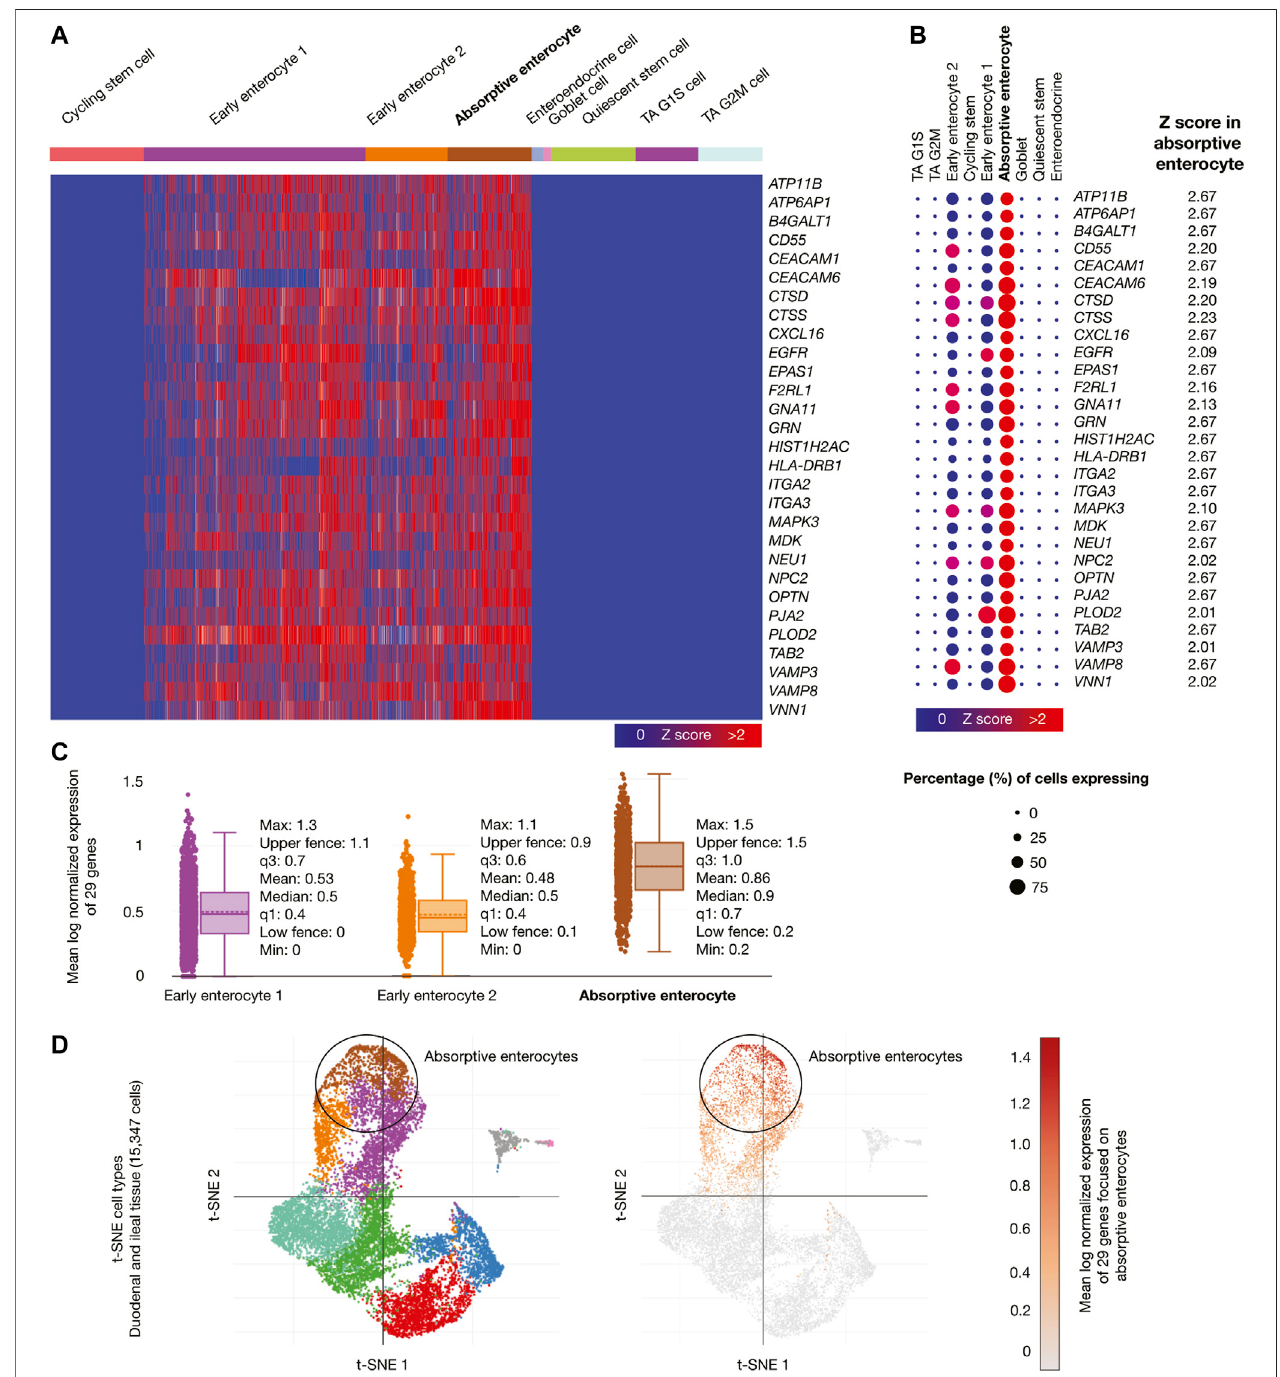
FIGURE 6 | Single-cell RNA-sequencing data analysis of the high-con fi dence immune system nodes in intestine cells. (A) Heatmap of signi fi cant overexpressed genes(Z-score > 2) inilealabsorptiveenterocytes. (B) Dotplot ofsigni fi cantoverexpressedgenesin ilealabsorptive enterocytes and percentageofcells expressing. (C) Box plots of intestine cell types according to their mean log normalized expression. (D) t-distributed stochastic neighbor embedding cell type and mean log normalized expression focused on ileal absorptive enterocytes.